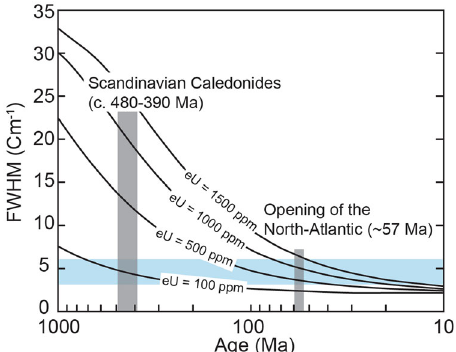
Fig. 4 Calculated radiation damage of single zircon grains as a function of time and eU. Evolution of radiation damage, measured as FWHM, through time of single zircon grains at different eU-content. The blue band shows the range of observed FWHM of both young magmatic and old inherited zircon from case 2. The expected FWHM for zircon grains formed or annealed during the opening of the North-Atlantic (~57 Ma) and the Caledonian orogen (c. 480 – 390 Ma) is shown as gray boxes for reference. Details about the calculations of the contour lines (radiation damage ages) are found in the “ Methods ”